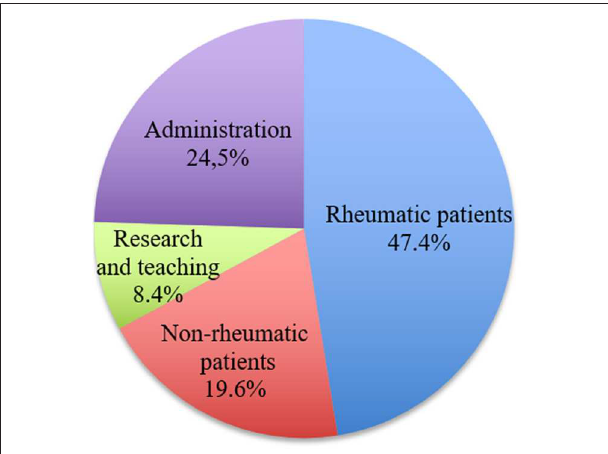
FIGURE 1 | Distribution of working hours per week in percent, all settings (hospital based, office based, both hospital and office based).